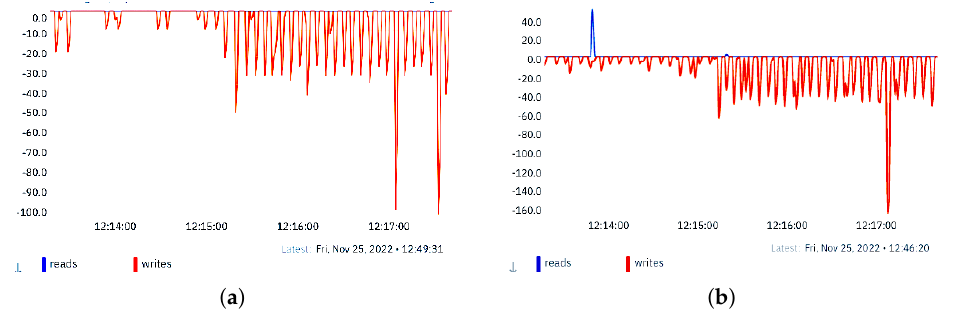
Figure 14. Disk bandwidth consumed by the IoT devices ( a ) Jetson, ( b ) Raspberry Pi (y → disk bandwidth in kb/s and x →